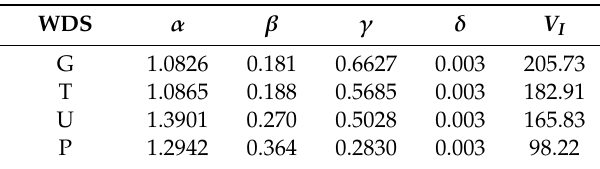
Figure 9. Cumulative out ‐ degree distribution functions limited in the range 1–100 N t , together with their power ‐ law fitting. Table 4. Values of power ‐ law and exponential fitting coefficients, and resulting Vulnerability Index, V I , for the real networks analyzed.